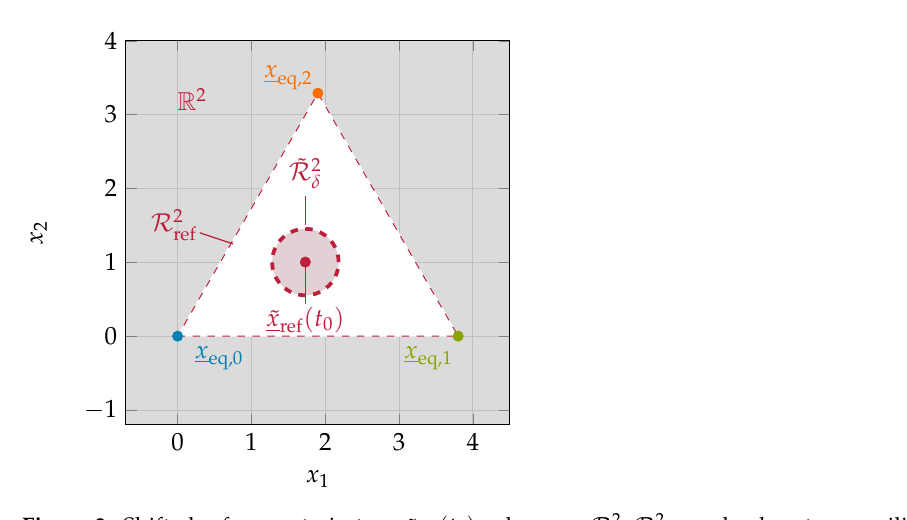
, R 2 , and subsystem equilibria x eq,0 , δ ref